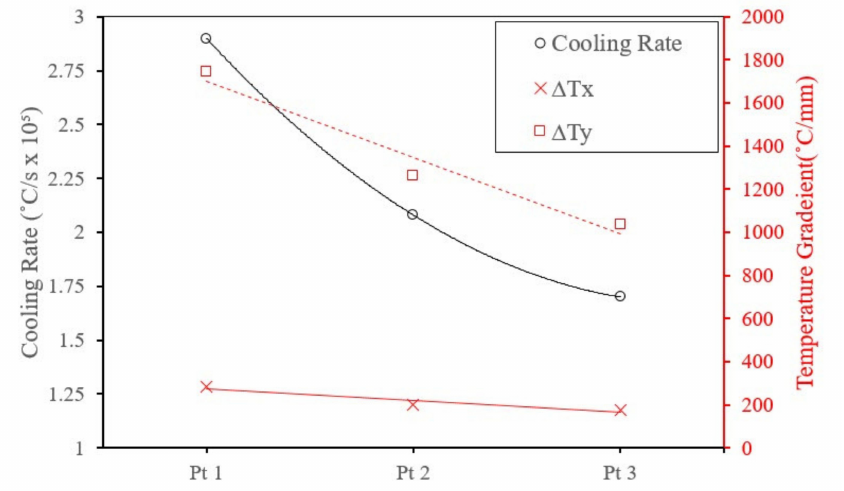
Figure 16. CR and temperature gradients at 220 W, 650 mm/s, and 0.12